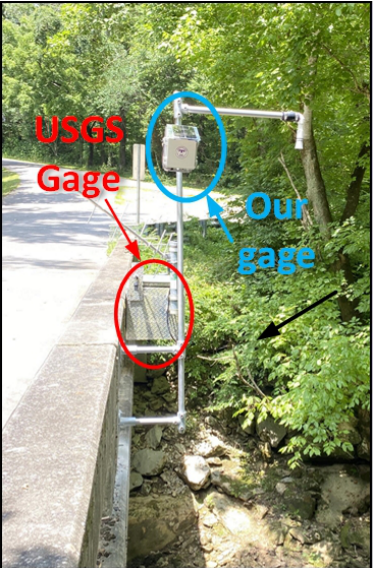
Figure 4. Location of our TNTech Gage in relation to USGS Gage